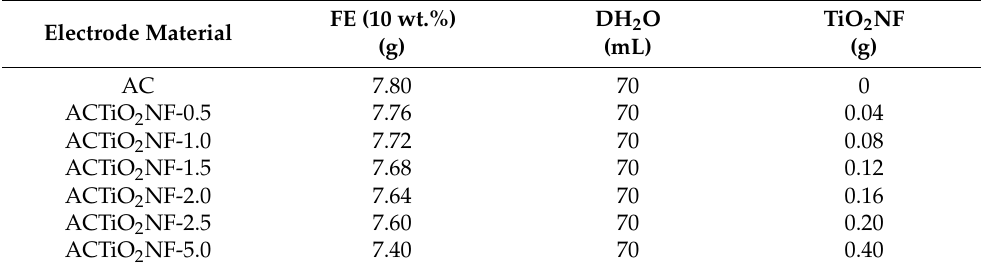
Table 1. Composition of flow